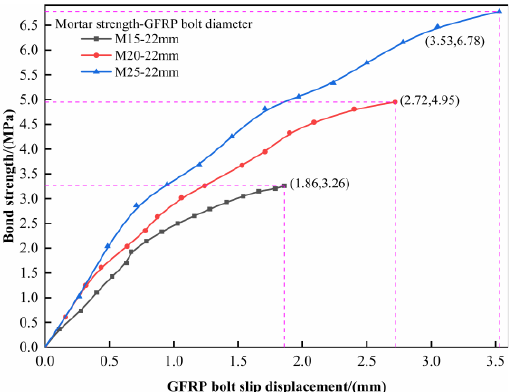
Figure 4. Relationship between bond strength and mortar strength.